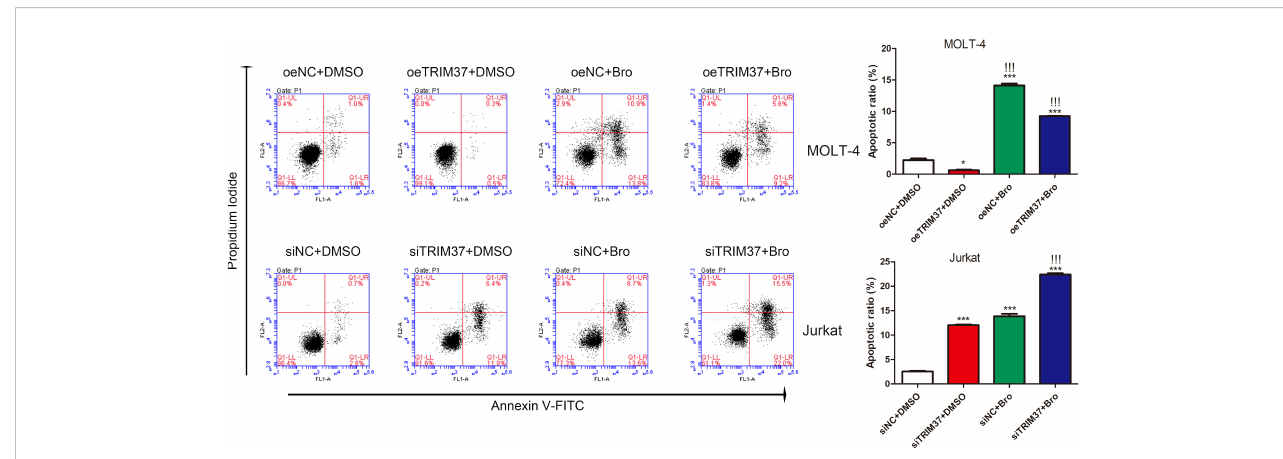
FIGURE 5 TRIM37 affected the therapeutic effect of Bortezomib on human T-ALL cells. * p < 0.05 compared with oeNC + DMSO; *** p < 0.001 compared with oeNC + DMSO; !!! p < 0.001 compared with oeTRIM37 +